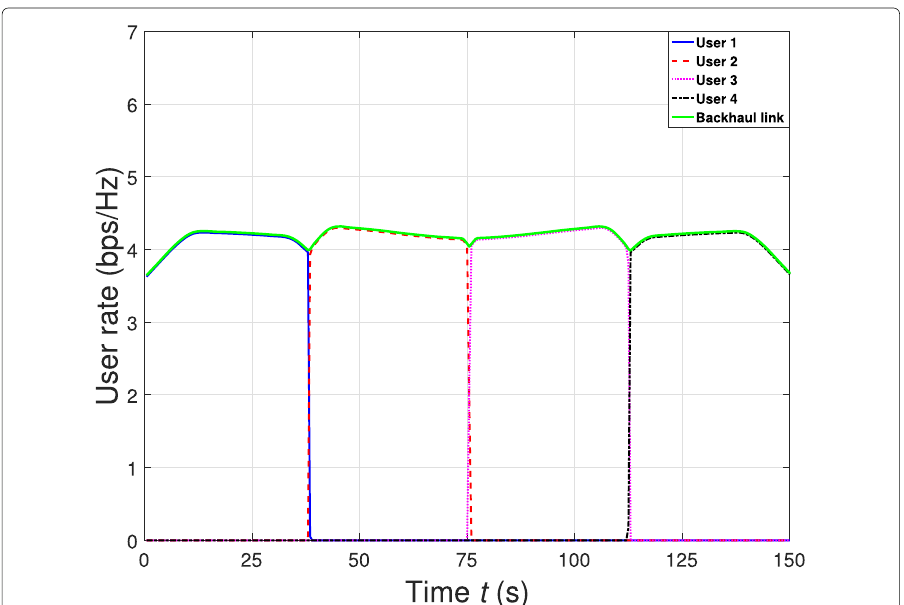
Fig. 6 Rates of the users and the backhaul link obtained by the proposed “B-P-T-OPT” schemes versus time t when T = 150 s